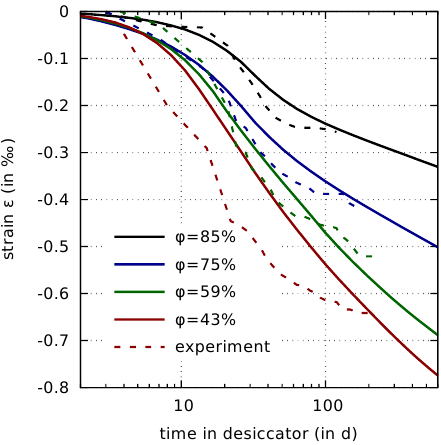
Figure 5. Comparison of drying shrinkage strains measured on thin concrete slices (dashed lines) with the respective computed results.